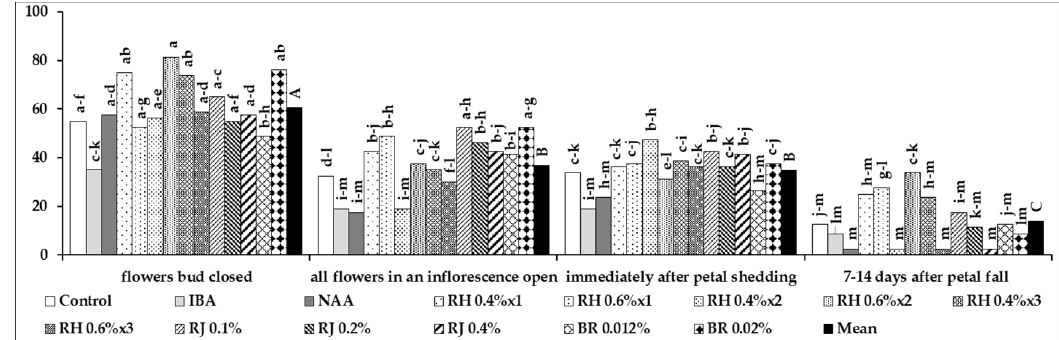
Figure 3. The influence of rooting enhancers on rooting percentage (%) of cuttings of Rosa ‘Maiden’s Blush’ harvested in four phenological stages of shoot. Control—the control cuttings; IBA 0.4%— Ukorzeniacz A aqua (0.4% IBA); NAA 0.2%—Ukorzeniacz B aqua (0.2% NAA); RH 0.4%×1, RH 0.6%×1— watering with 0.4% or 0.6% Bio Rhizotonic (10 mL) after planting; RH 0.4%×2, RH 0.6%×2—watering with 0.4% or 0.6% Bio Rhizotonic (10 mL) after planting and 10 days later; RH 0.4%×3, RH 0.6%x3— watering with 0.6% Bio Rhizotonic (10 mL) after planting, 10 and 20 days later; RJ 0.1%, RJ 0.2%, RJ 0.4%—watering with 0.1%, 0.2% or 0.4% Root Juice™ (10 mL) after planting; BR 0.012%, BR 0.02%— watering with 0.012% or 0.02% Bio Roots (10 mL) after planting. Different small letters indicate significant interactions between phenological stage and treatment (two ‐ way ANOVA). Different capital letters indicate significant differences between phenological stages. The Duncan’s test ( α = 0.05) was used.